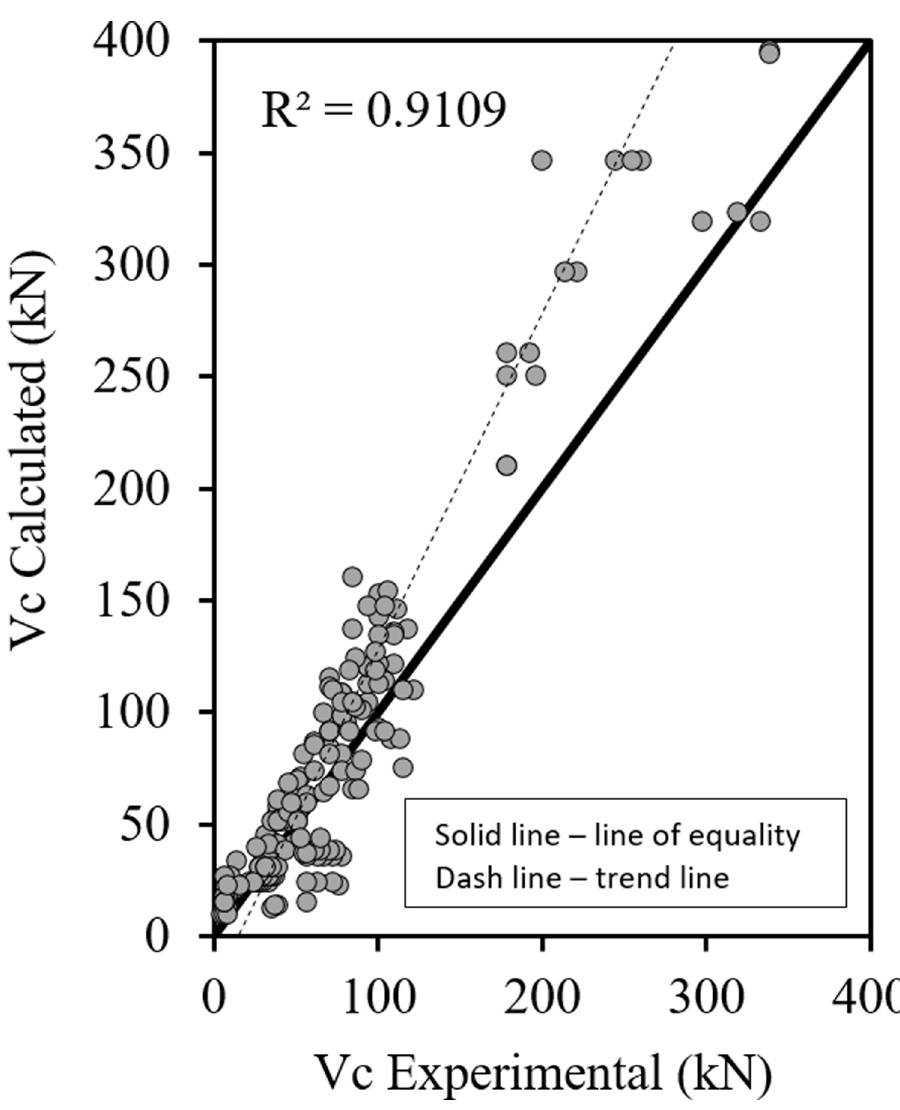
Fig 7. Shear strength of HSC beams (Eq 9).